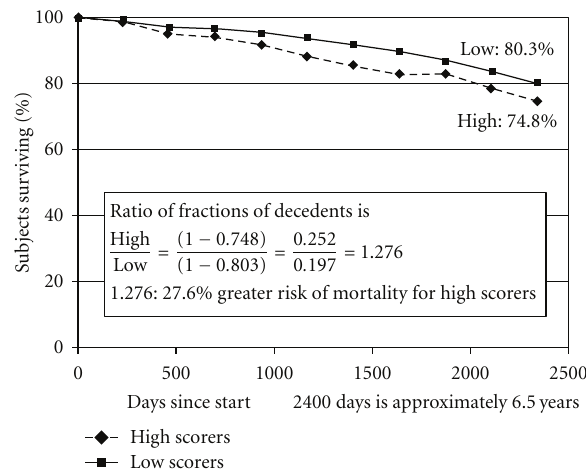
Figure 3: Survival in the groups with high and low scores on Distrust over approximately 6.5